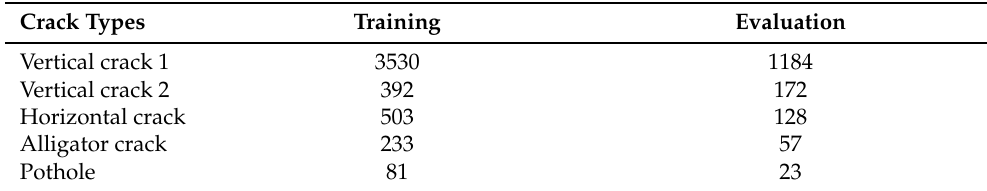
Table 26. Damage occurrences in the P18